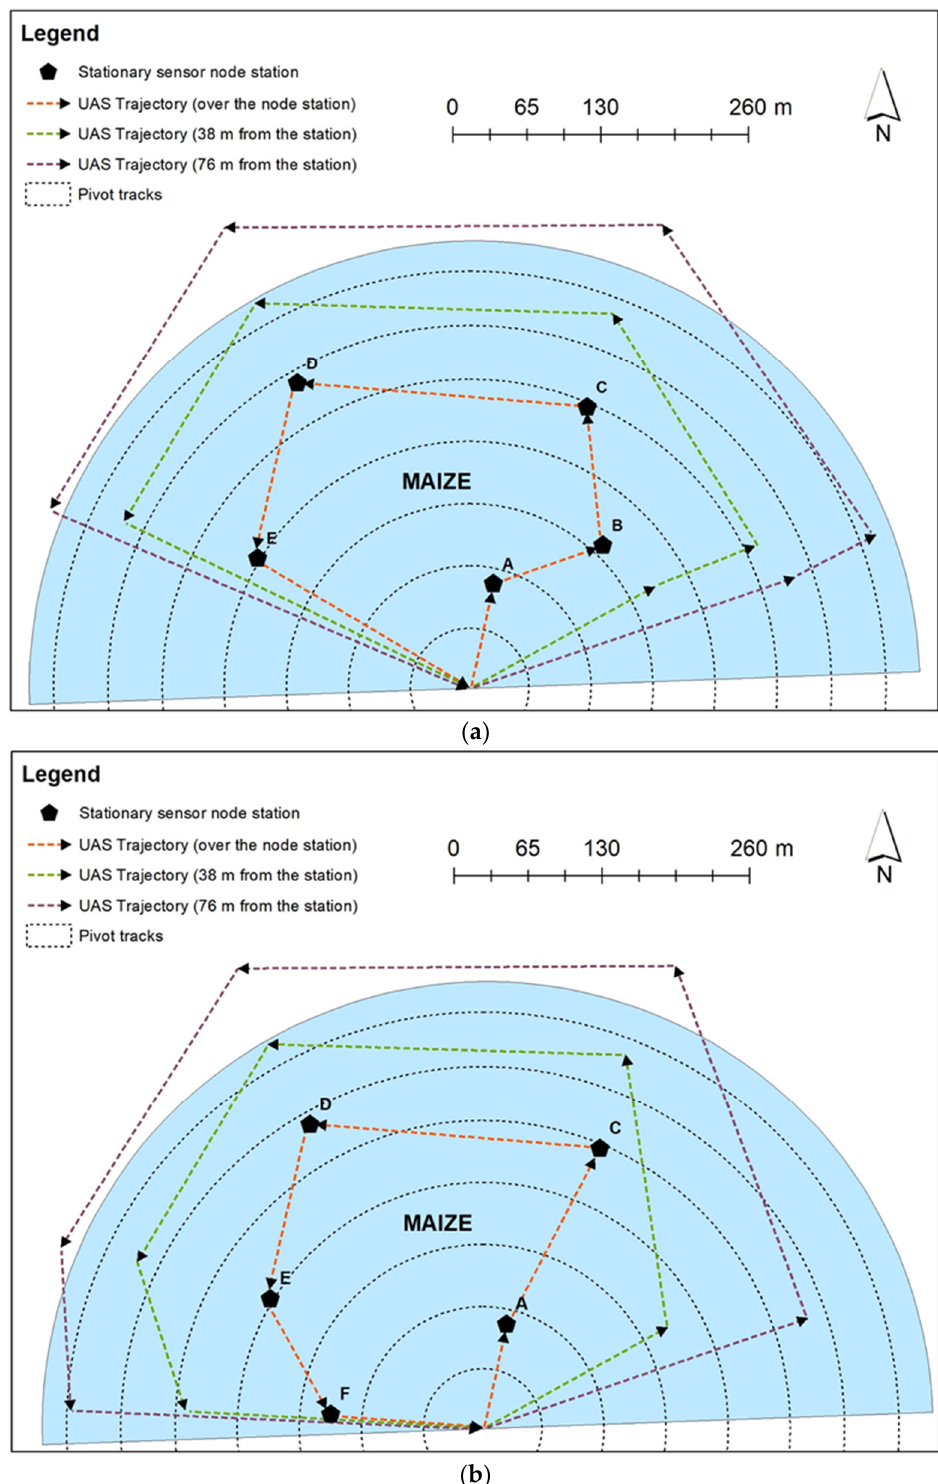
Figure 4. Location of stationary sensor node stations and the trajectory of UAS for five replications during the 2021 growing season: ( a ) before the collapse of the station at point ‘B’, and ( b ) after the installation of the station at point ‘F’. There were three replications of UAS flights: (i) over the station; (ii) 38 m from the station; and (iii) 76 m from the station.